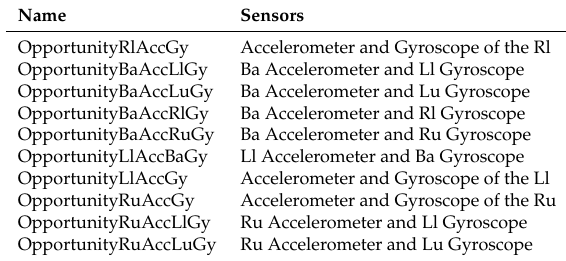
Table 1. Data sets obtained from the data of the Inertial Measurement Units (IMUs) of the Opportunity data set.